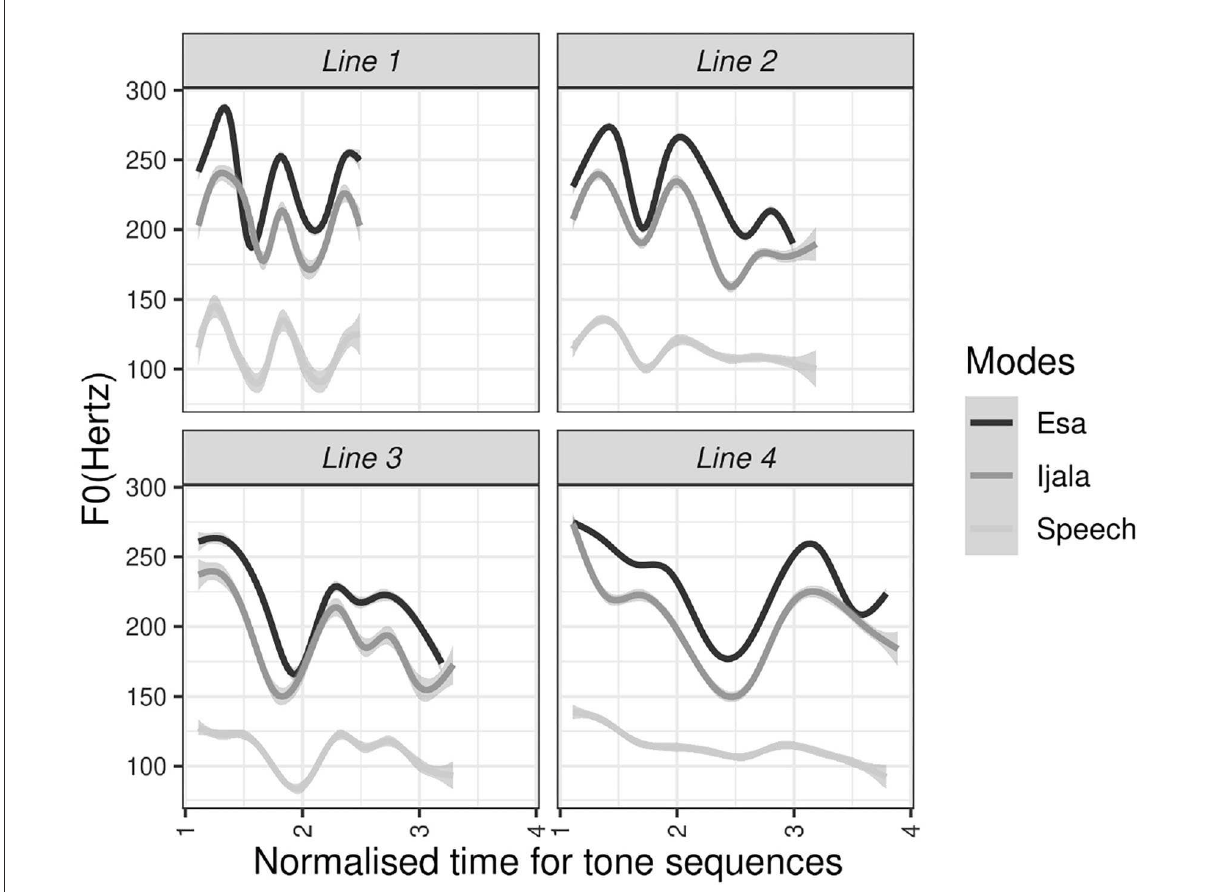
FIGURE4 Pitch contours of each line in speech and poetic